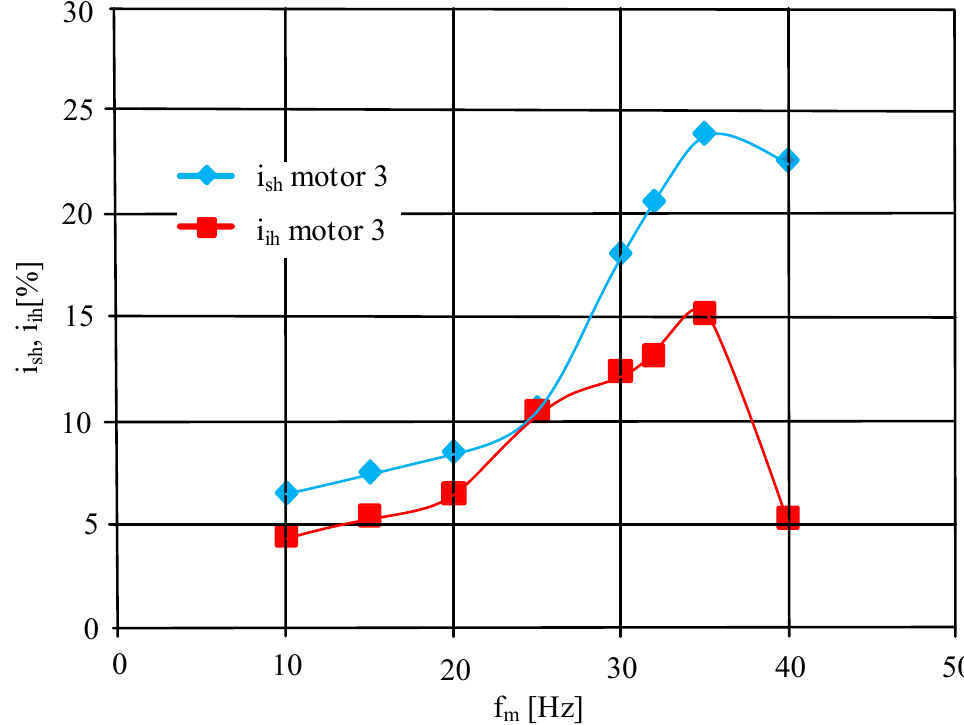
Figure 22. Measured current subharmonics and interharmonics versus the frequency of the amplitude modulation for Case A. The frequency components are related to the rated current.